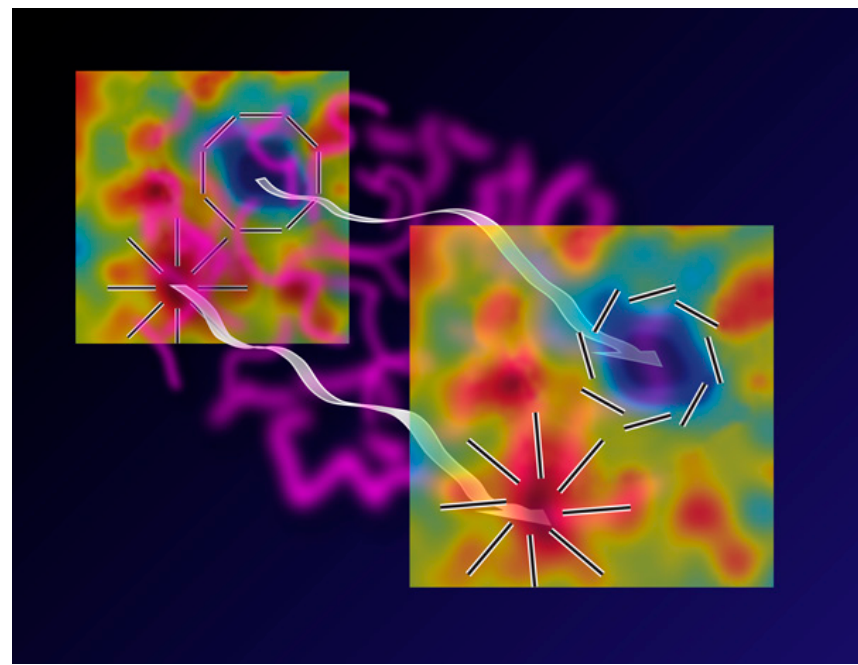
Figure 23. Twisting E-mode to B-mode: When the cosmic microwave background (CMB) originated 13.7 billion years ago (represented by the map on the left), it was polarized with radial and tangential patterns around hot (red) and cold (blue) regions, respectively. This E-mode polarization has been previously observed in CMB measurements. However, gravitational lensing from intervening matter (purple) causes a slight twist in the primeval pattern (shown in the map on the right). This B-mode polarization has been detected for the first time by the SPT Collaboration. (Credit APS/Alan Stonebraker, https://physics.aps.org/articles/v6/107).